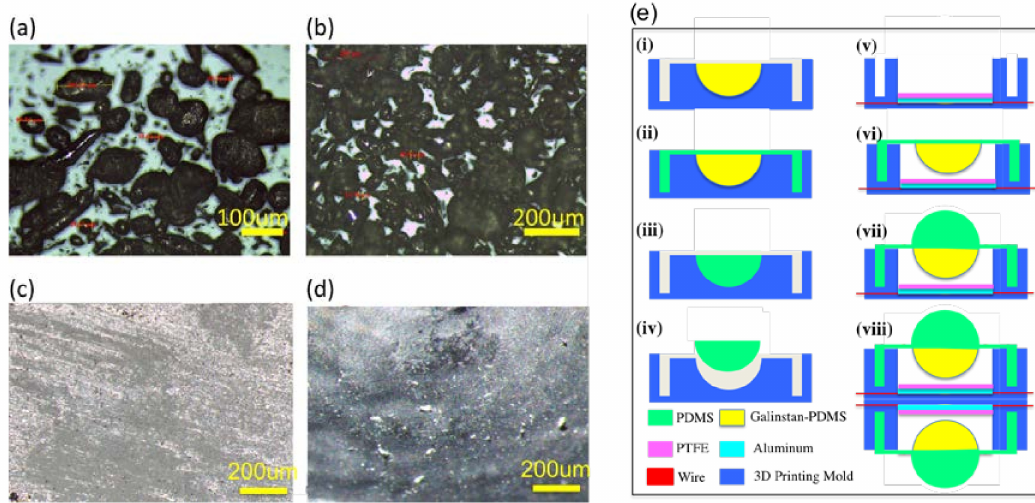
Figure 3. Structure of galinstan-polydimethylsiloxane (PDMS) mixture and fabrication process of the sensor. ( a ) Optical microscope image of the monolayer structure of galinstan and PDMS mixture. ( b ) Multilayer structure of the mixture. ( c ) Microscope image of the conductive layer on the semi-sphere surface under an external force. ( d ) Microscope image of the semi-sphere surface when the external force is removed. ( e ) Fabrication process of the six-axis self-powered